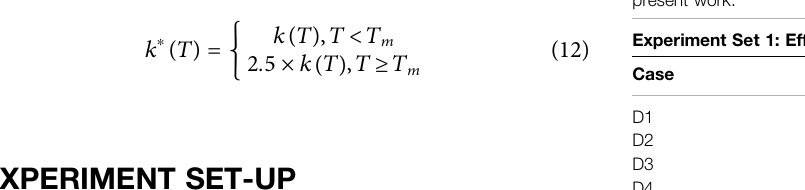
TABLE 2 | Description of the cases and process parameters used in the present